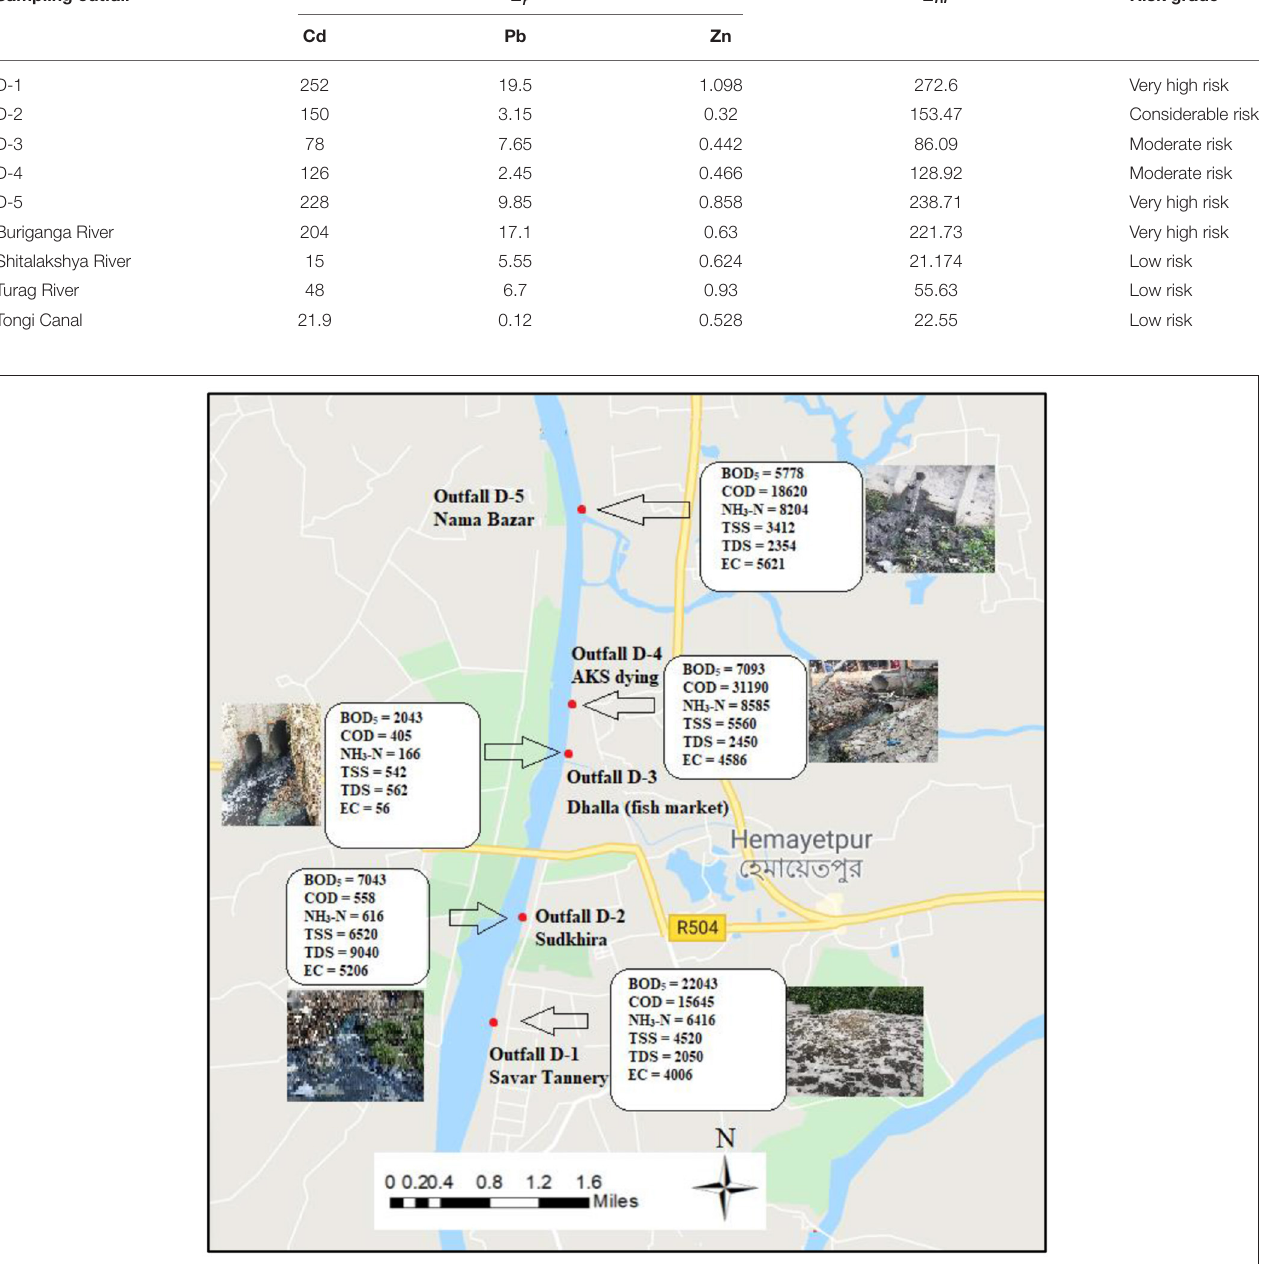
TABLE 4 | Ecological risk characterization of the peripheral rivers in Dhaka city. Sampling outfall